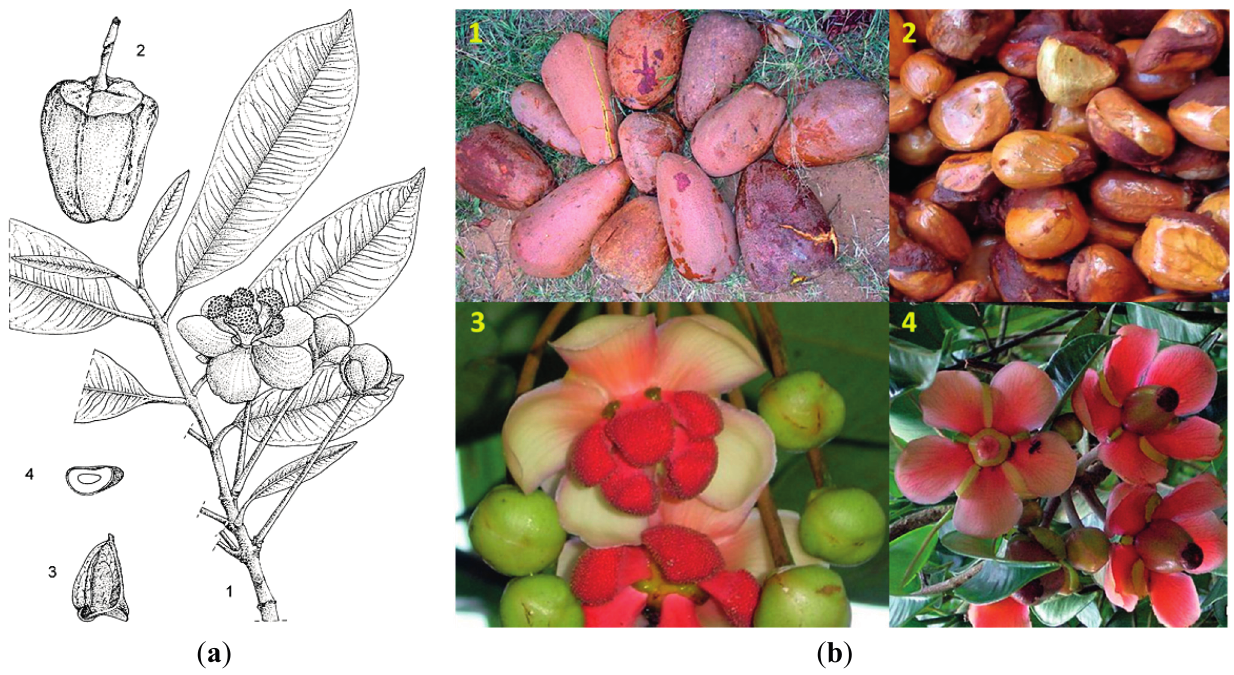
Figure 3. Line drawing detailing characteristic botanical features of ( a ) Allanblackia stuhlmannii ( 1 , twig with male flowers; 2 , fruit; 3 , seed; and 4 , seed in cross section); and ( b ) photos of A. stuhlmannii ( 1 , fruits; 2 , seeds; 3 , male flowers; and 4 , female flowers). Line